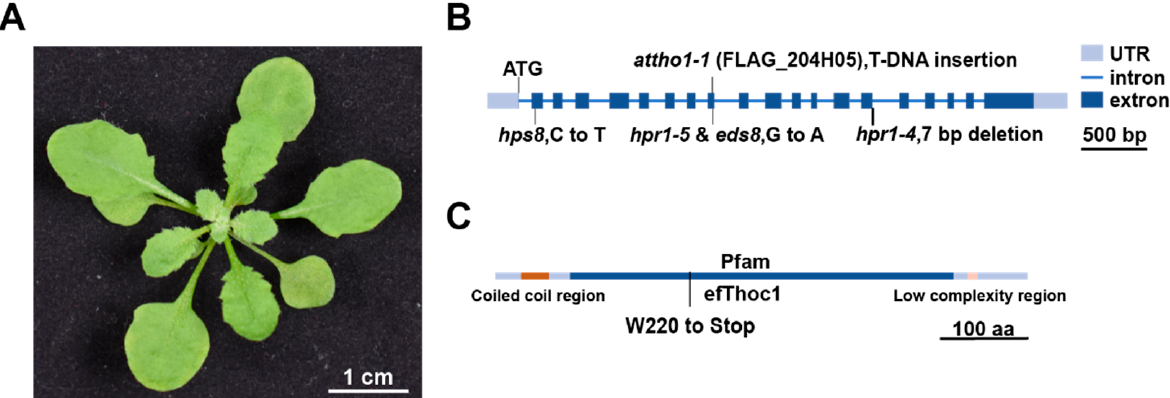
Figure 3. The eds8 mutant is positional cloned to THO1 using mapping-by-sequencing. ( A ) The serrated leaf phenotype of the eds8 mutant. ( B ) Schematic representation of the EDS8 gene. Untranslated regions (UTR) are represented as grey boxes, exons as dark blue boxes and introns as blue lines. The positions and mutation forms of eds8 , hpr1-5 and other previous published mutants are indicated. ( C ) Schematic representation of EDS8 protein. The mutation site of eds8 is marked. The coiled coil regain of EDS8 protein is represented by red box, the Pfam efThoc1 domain predicted by SMART by dark blue box, and low complexity region by pink box.